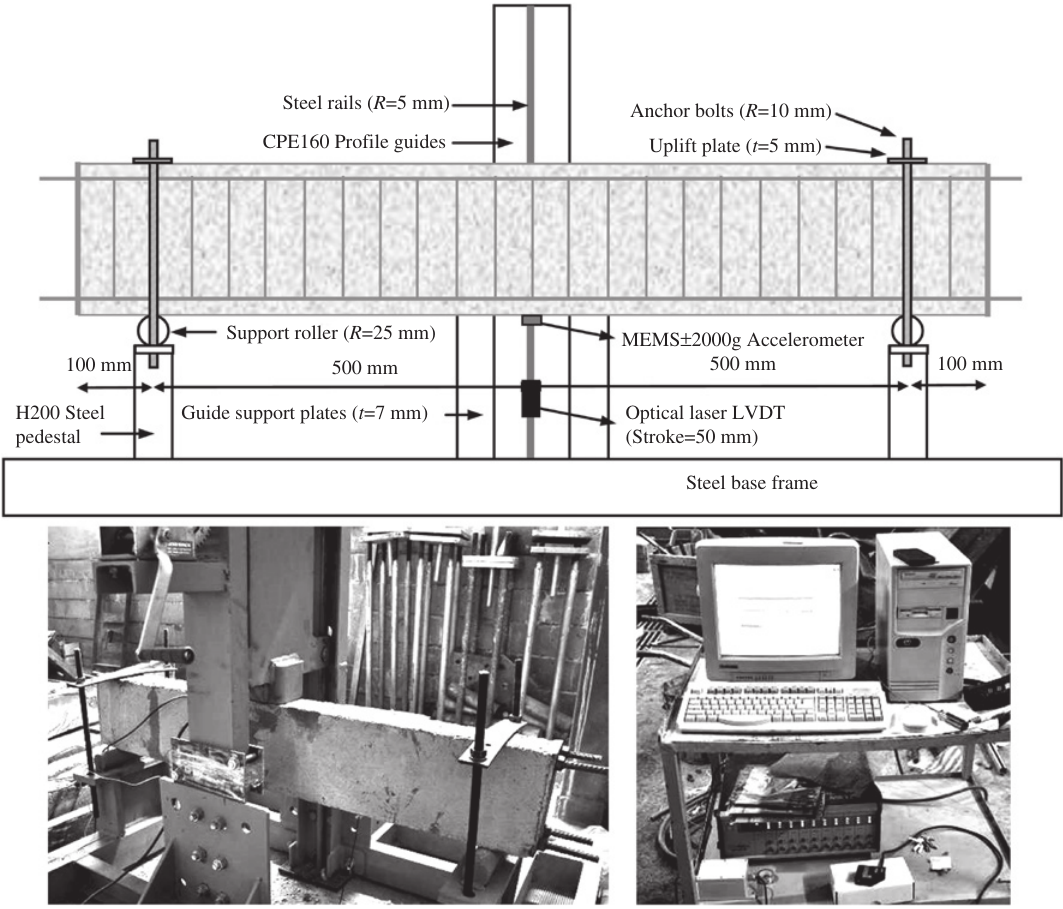
Figure 3: Setup and instrumentation used for drop weight impact